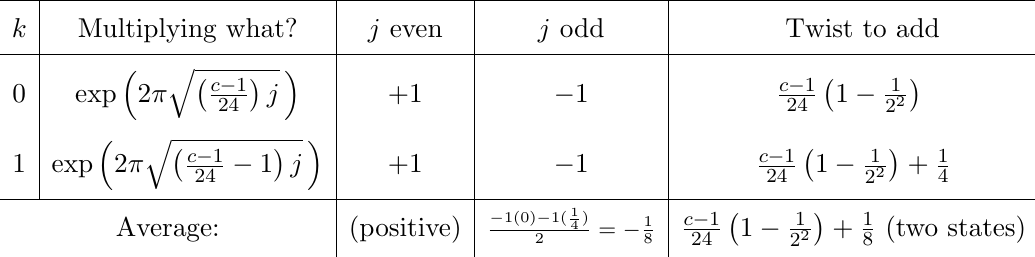
Table 1 . In this table, we look at the negativity in the Virasoro vacuum character’s modular sum. The entries in the third and fourth columns evaluate (3.11) at s = 2 (the smallest value of s such that (3.11) is non-vanishing) for the values of k and j indicated. The second column indicates the magnitude of this term to the partition function at large j or large c , and the last column indicates the twist necessary to add in order to obtain a comparable density of states from a non-vacuum state. We see there is negativity for odd spins. At (cid:12)nite j and large c , for both of these, we can cure the negativity by introducing two states with min( h; (cid:22) h ) (cid:20) c (cid:0) 1